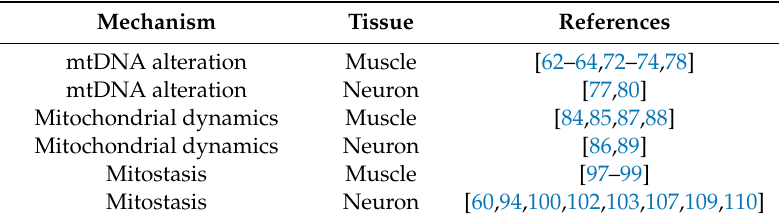
Table 2. Mechanisms of impaired mitochondrial function with